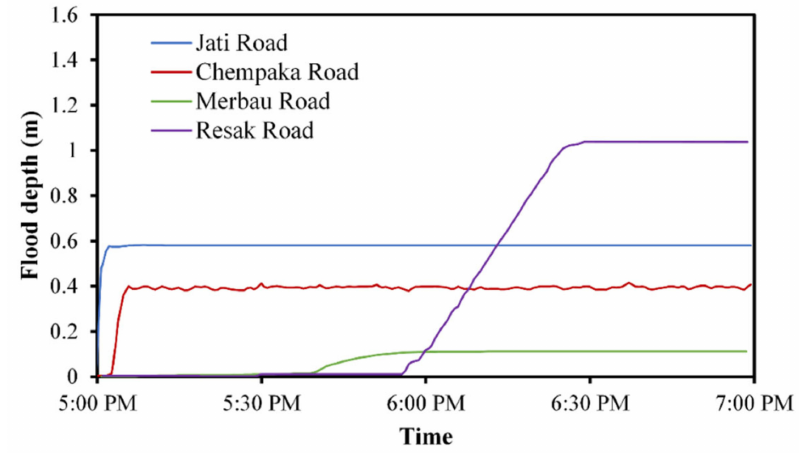
Figure 8. Flood depth at different locations in Kampung Melayu